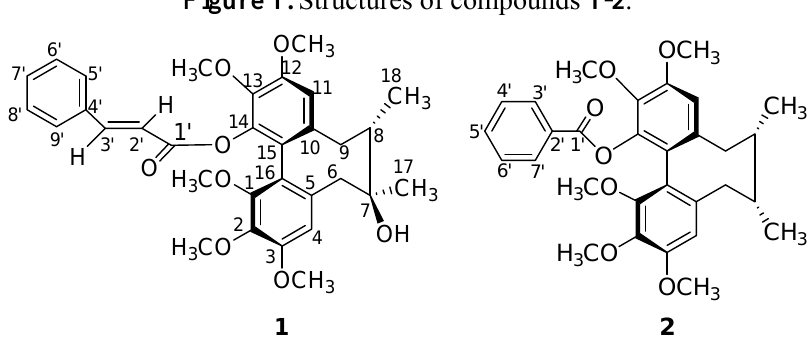
Figure 1. Structures of compounds 1-2